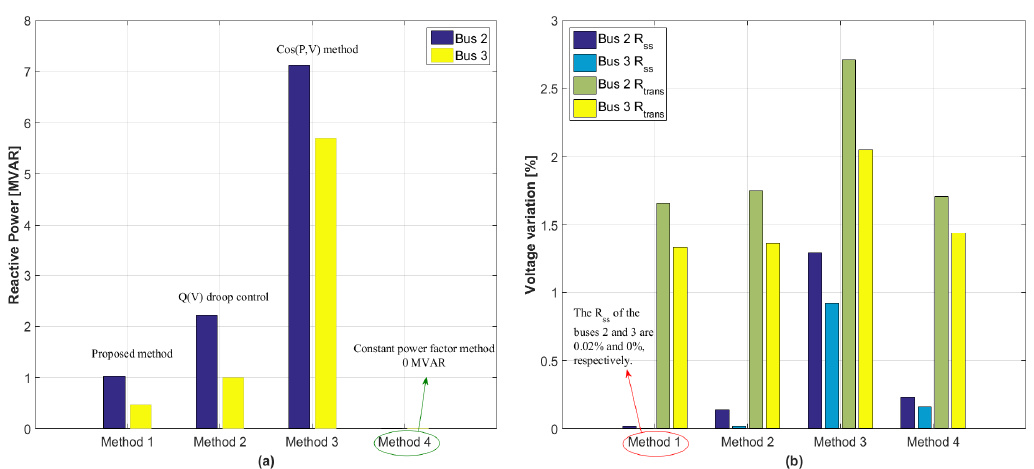
Figure 9. Comparison results for minimization of voltage variation in Case 2. ( a ) Total reactive power generation at buses 2 and 3 ( b ) Voltage variation at buses 2 and 3.